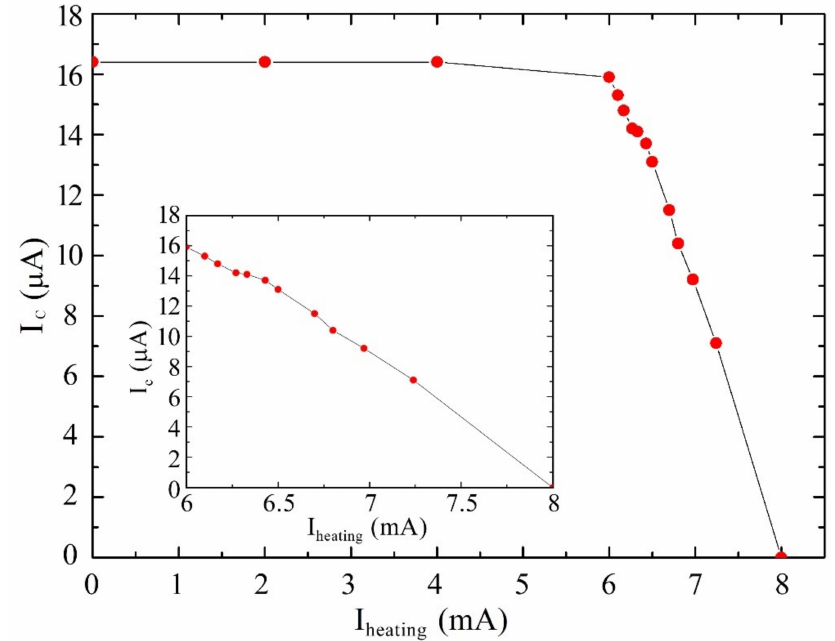
Figure 3. Critical current of the SQUID magnetometer as a function of the current sent into the integrated heater (red dots). After a value of 6 mA, the critical current decreases in appreciable way. The same curve is shown in the inset where the I heating starts from 6 mA to better highlight the behavior of the curve and evaluate the rate of decrease in the critical current. The solid lines are